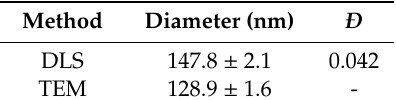
Table 1. Average hydrodynamic diameter of particles measured by means of dynamic light scattering (DLS) and average.